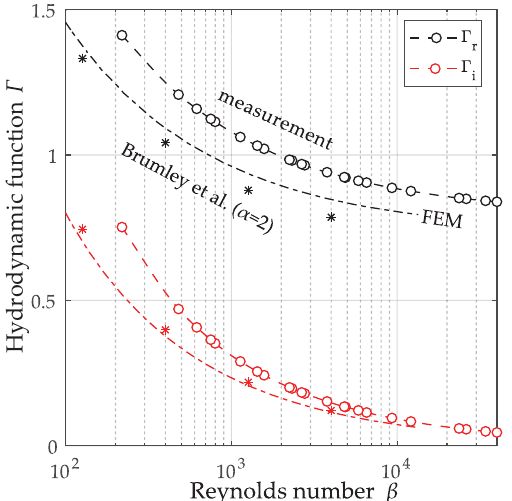
Figure 9. Estimated hydrodynamic function using Equation (A17) ( ◦ ) and comparison with 2D simulation of rectangular cross-section (- · -) and tabulated values from [21] for aspect ratio α = 2, which is the closet match to the actual α =